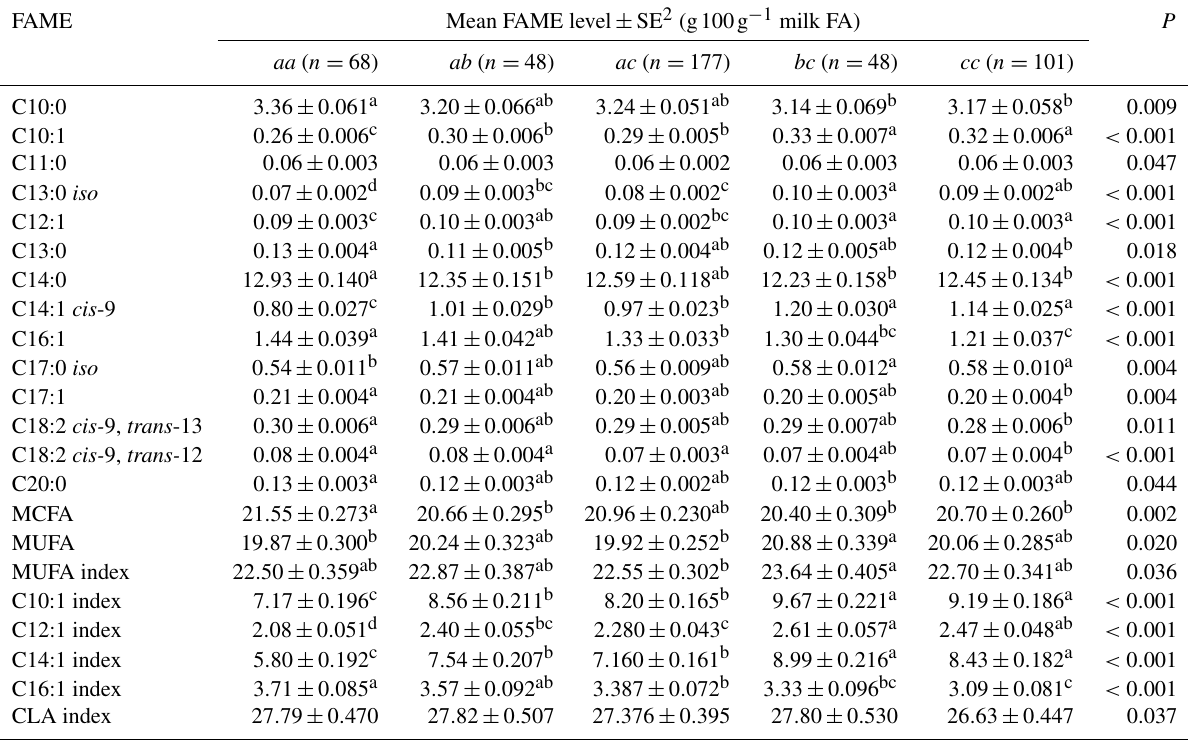
Table 5. Association between milk fatty acid levels and 3 (cid:48) -UTR genotypes 1 .